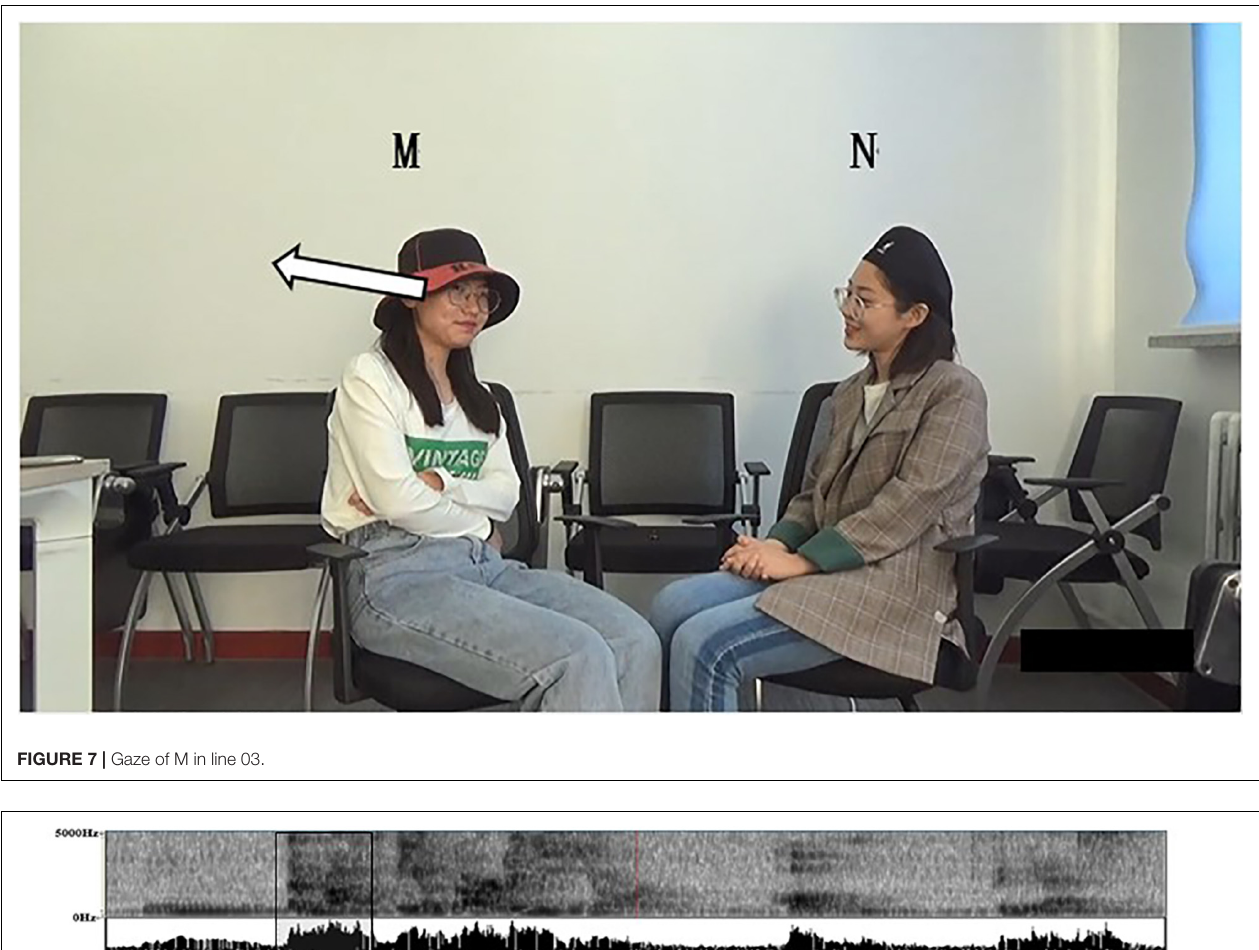
FIGURE 7 | Gaze of M in line 03.